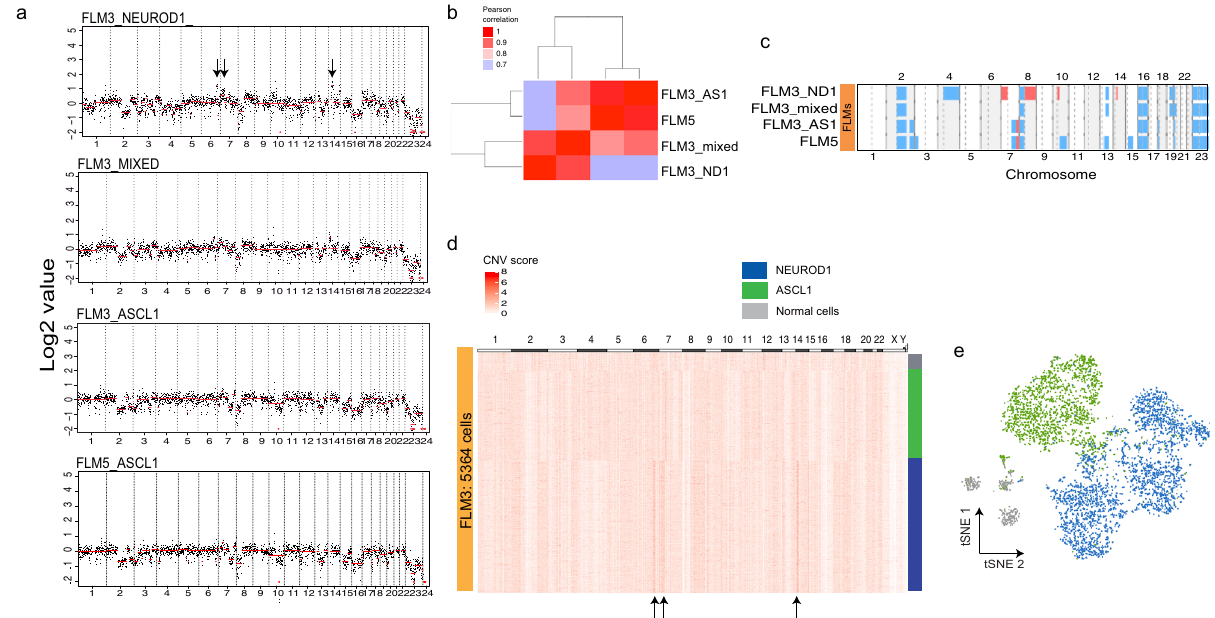
Fig. 4 The NEPC subtypes are distinct clones. a Genome-wide CNV pro fi les inferred from the scATAC-seq clusters in FLM3 and FLM5. Black dots are values in 1 MB regions and the red line is the result of running a segmentation algorithm on the data (see “ Methods ” ). Arrows point to differences seen in CNVs across the clusters. b Sample pairwise Pearson ’ s correlation of the CNV pro fi les. c Summary heatmap of the scATAC-seq-inferred CNV alterations across all of the patient samples (blue represents losses and red represents gains). d Heatmap of the single-cell CNV analysis of FLM3 where each column is a 2 MB bin tiled across the genome and the rows are individual cells that have been clustered with K -means. Arrows point to CNV differences observed here and in the cluster level analysis. e tSNE plot of FLM3 scATAC-seq data colored by the cluster each cell was partitioned into by the inferred CNV alterations. Those three clusters clearly correspond to NEUROD1 (blue), ASCL1 (green), and normal cells (gray). Source data are provided as a Source Data fi